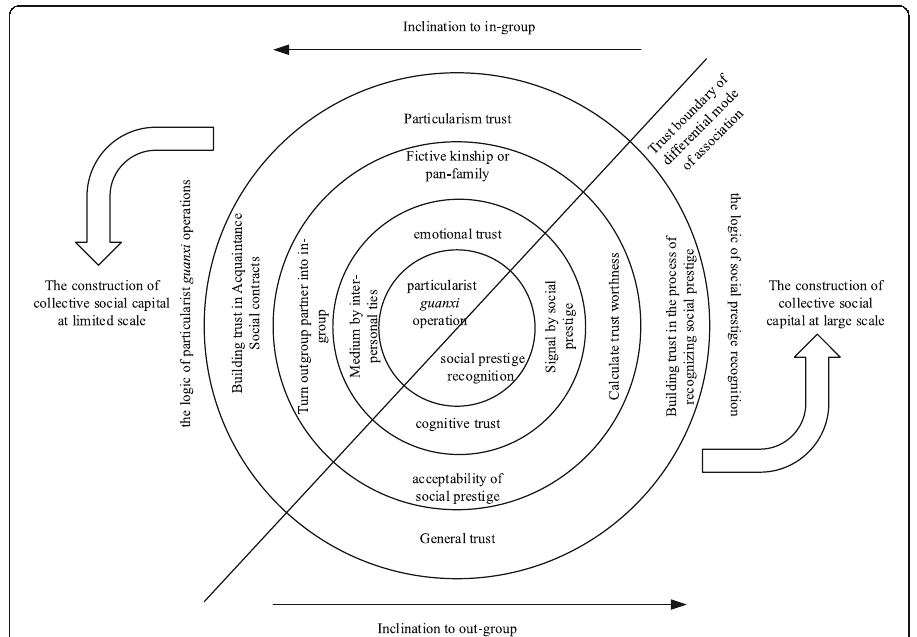
Fig. 1 Two theoretical pathways of collective social capital construct inside and outside of the differential mode of